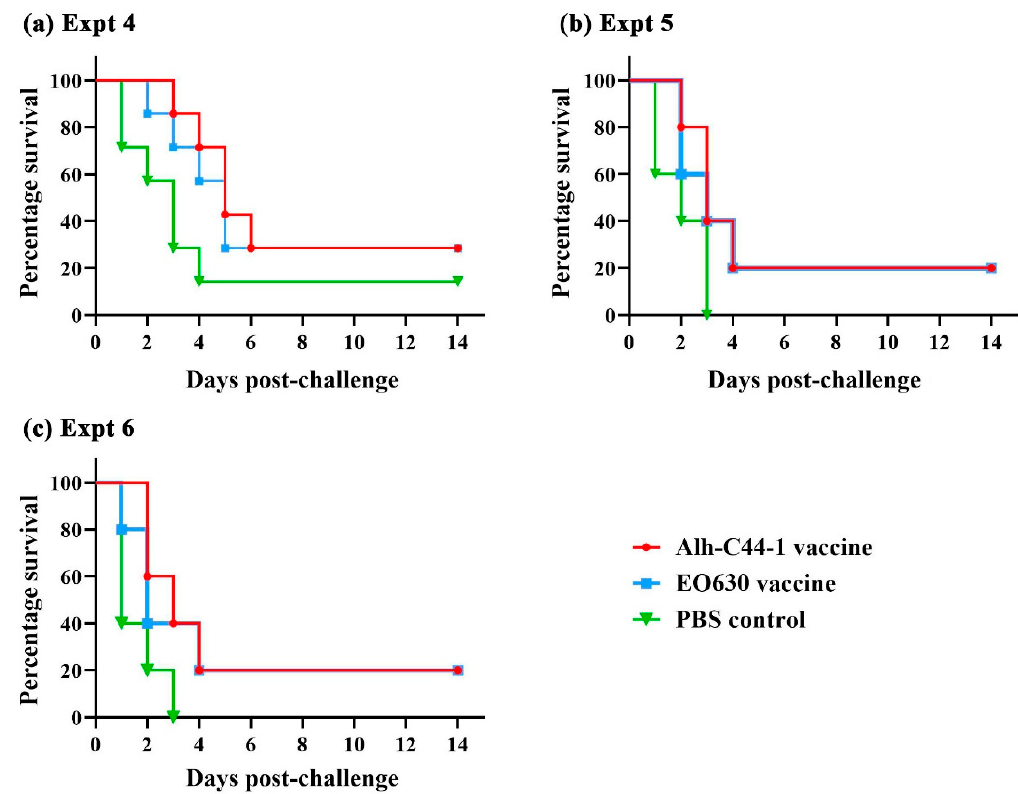
Figure 4. Survival rates of a mouse model immunized with traditional vaccines after challenge with serogroup D strains.